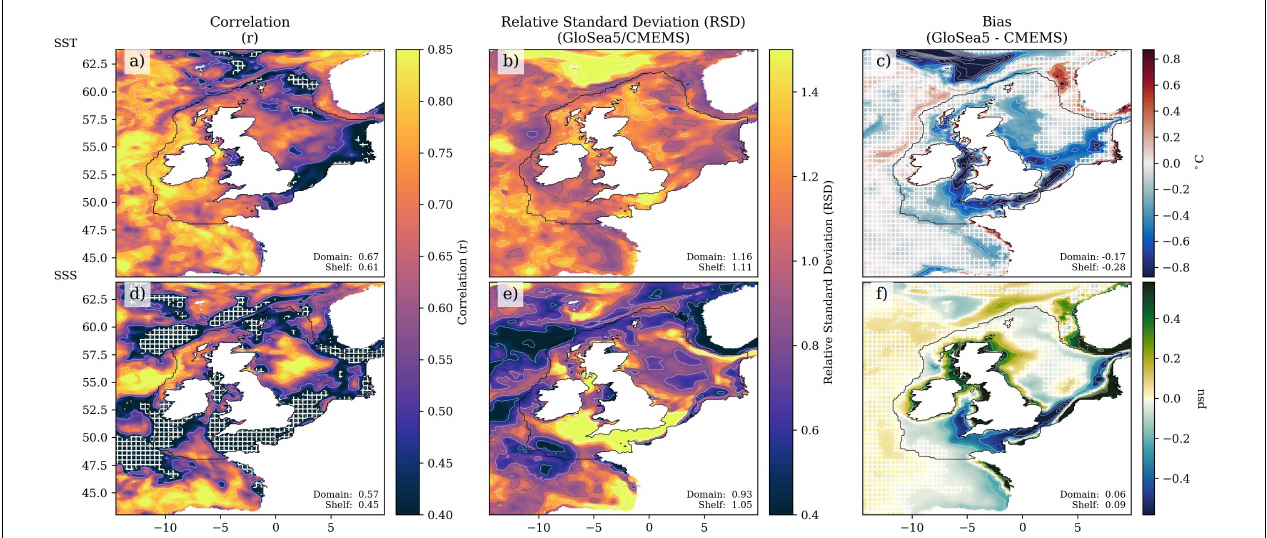
FIGURE 5 | Assessment of GloSea5 forecast skill of the NWS winter for SST (a–c) and SSS (d–f) . The winter (DJF) mean CMEMS is compared to GloSea5 reforecast ensemble mean (DJF predicted from November). The (pointwise) statistics compare the pair of 23-year time-series, giving (a,d) : the correlation (with insignificant values shaded out); (b,e) : relative standard deviation ( RSD , the standard deviation of the GloSea5 ensemble member time-series (23 years and 28 ensemble members) divided by the standard deviation of CMEMS time-series); and (c,f) : the bias (repeated from Figures 1c,f for ease of comparison). The domain and shelf mean are given for each field. NBT is given in Supplementary Figure 10